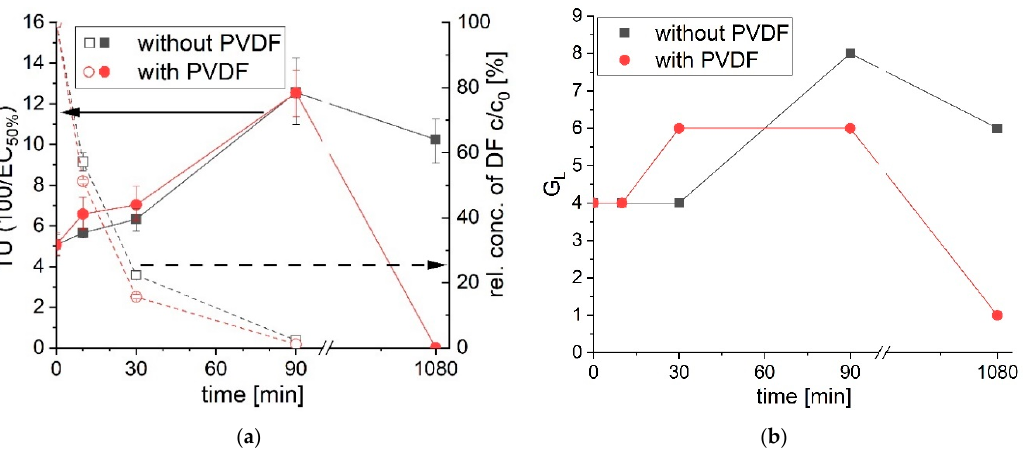
Figure 8. ( a ) Change of toxicity to Vibrio fischeri after irradiation of diclofenac with UVA light with and without PVDF (left axis) expressed in toxicity units (TU = 100/EC 50% , EC 50% is the effect concentration at which 50% of effect occurs; the higher the TU, the higher the toxicity). The concentration decrease of diclofenac after irradiation was analyzed via HPLC (right axis). In ( b ) is the toxicity towards Vibrio fischeri after irradiation of diclofenac with UVA light expressed in G L levels. The G L value is the dilution level at which the inhibition is below 20% for the first time (the higher the G L level, the higher the toxicity). All values below 20% inhibition are normal test fluctuations. Level 1 (80% volume fraction), level 4 (25% volume fraction), level 6 (16.66% volume fraction), level 8 (12.5% volume fraction).